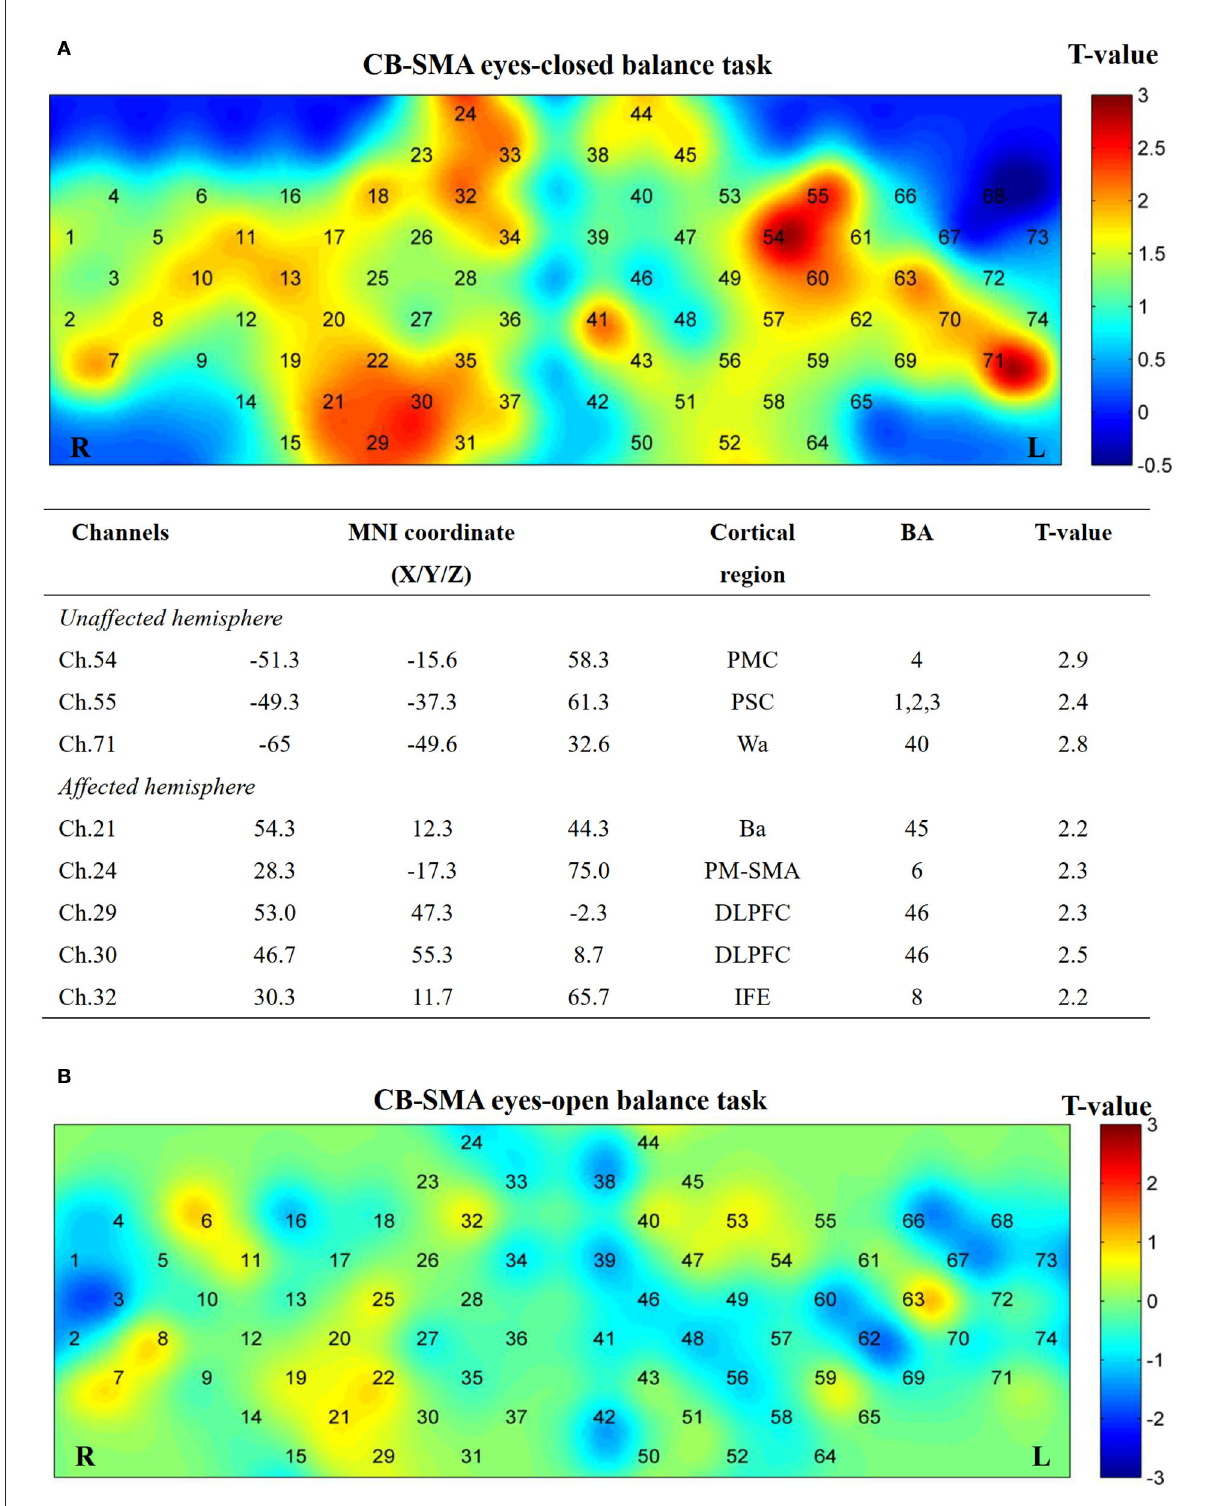
FIGURE7 Cortical activation map in CB-SMA group in EC condition (A) and EO condition (B) . Results from paired t -test of beta value between post- and pre-CB-SMA iTBS protocol. None channels passed FDR correction. Channels with a meaningful trend have been